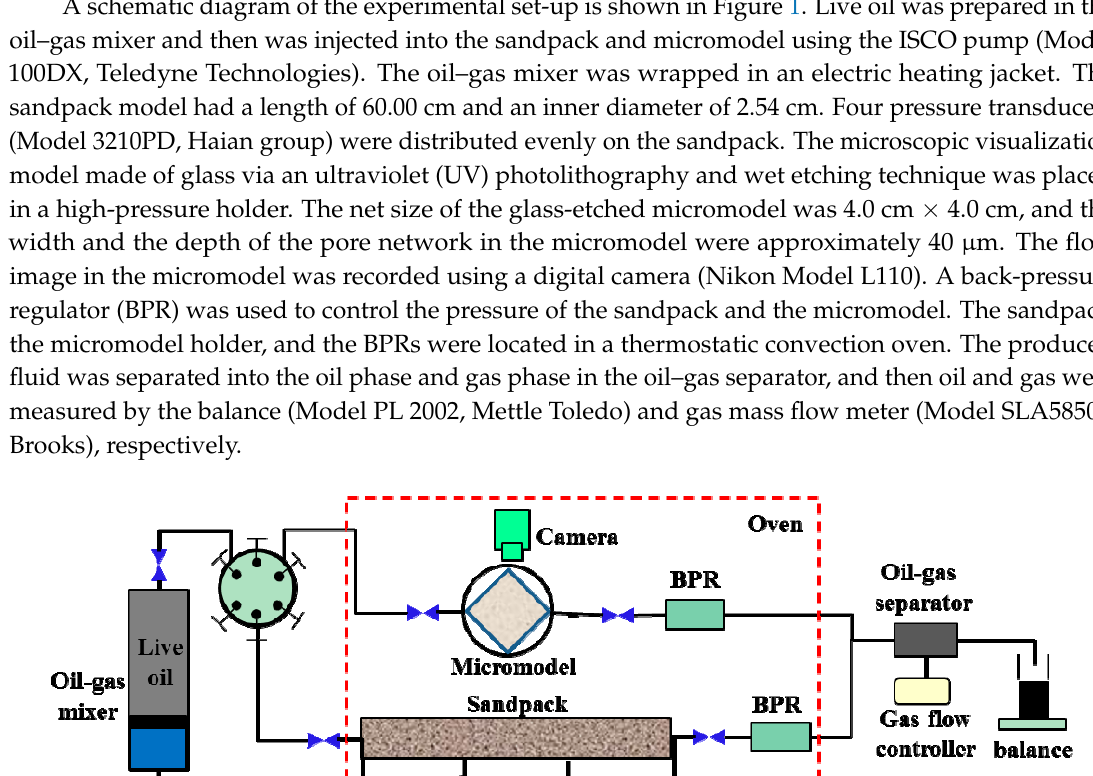
Table 3. Parameters for sandpack depletion experiments.